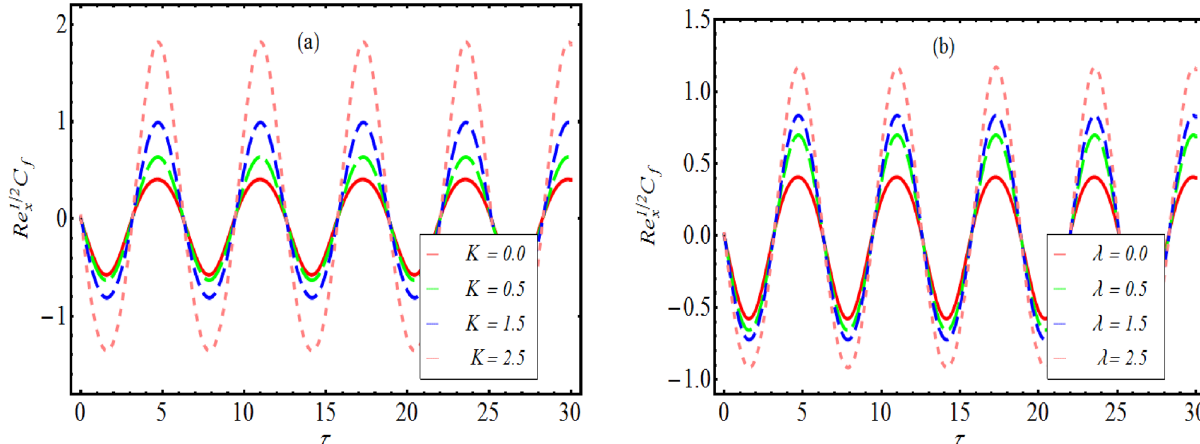
1 / 2 x C f for various values of ( a ) K and ( b )